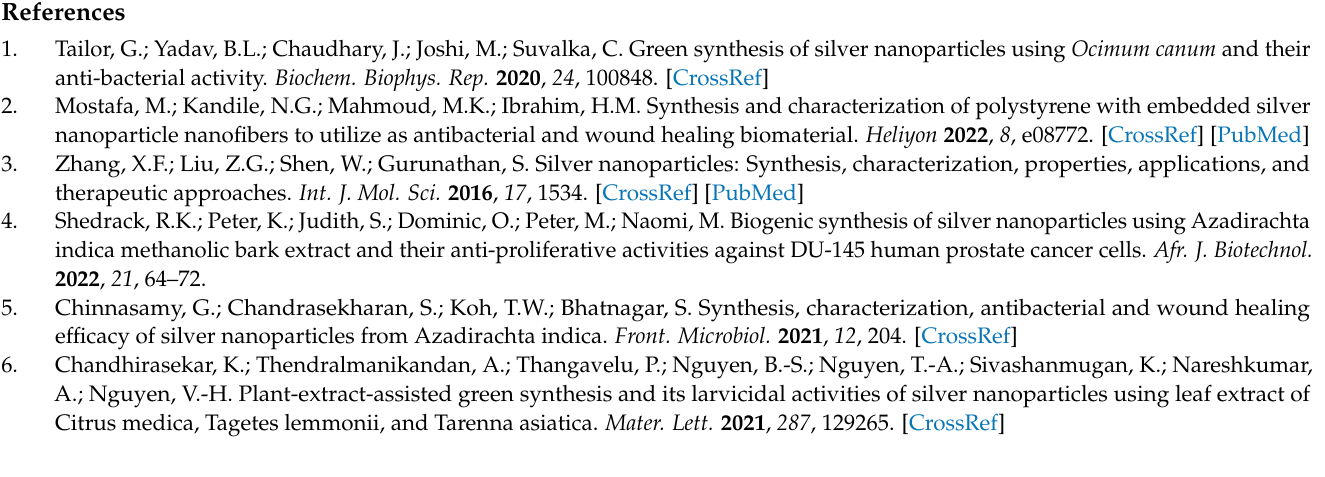
AgNPs. Figure S1: Main individual effect plot showing how the factors (percentage of ethanol, ratio m / v , and extraction time) influence the volume yield. Figure S2: Main individual effect plot showing how the factors (percentage of ethanol, ratio m / v , and extraction time) influence the mass yield. Figure S3: Main individual effect plot showing how the factors (percentage of ethanol, ratio m / v , and extraction time) influence the inhibition diameter of S. aureus ATCC 6538. Figure S4: Interaction plot displaying how the relationship between the factors involved in the extraction process (percentage of ethanol, ratio m / v , and extraction time) influence the volume yield. Figure S5: Interaction plot displaying how the relationship between the factors involved in the extraction process (percentage of ethanol, ratio m / v , and extraction time) influence the mass yield. Figure S6: Interaction plot displaying how the relationship between the factors involved in the extraction process (percentage of ethanol, ratio m / v , and extraction time) influence the inhibition diameter of S. aureus ATCC 6538. Figure S7: Contour plot showing the evolution of the volume yield as a function of the ratio m / v and the percentage of ethanol. Figure S8: HPLC-MS/MS chromatogram of the optimized extract of Enantia chloranta bark. Figure S9: Particle size and distribution using photon cross-correlation spectrometry. Figure S10: Stability measurement of green-synthetized silver nanoparticles. Figure S11: Survival rate of Galleria mellonella challenged with various concentrations of